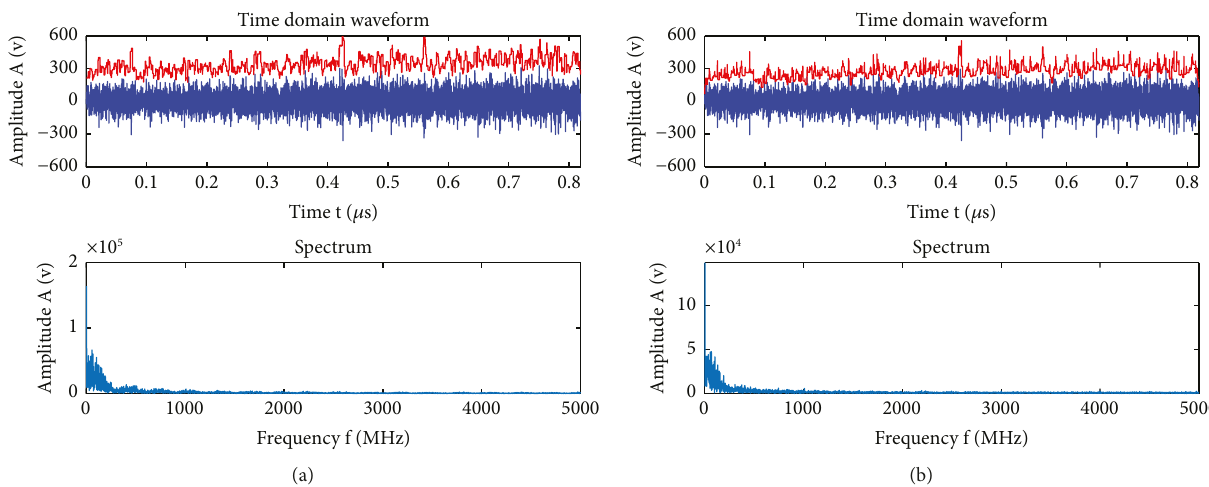
Figure 6: Morphological gradient signals and spectrum of (a) dilate-erode and (b)